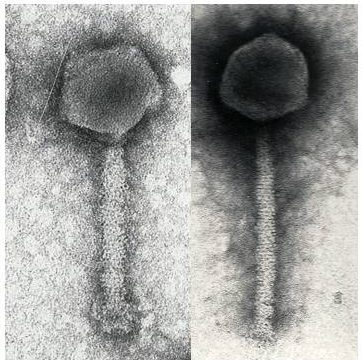
Figure 2. Electron micrograph of phages ΦW-14 (left) and phage SP-15 (right) stained with 2% w / v uranyl acetate.